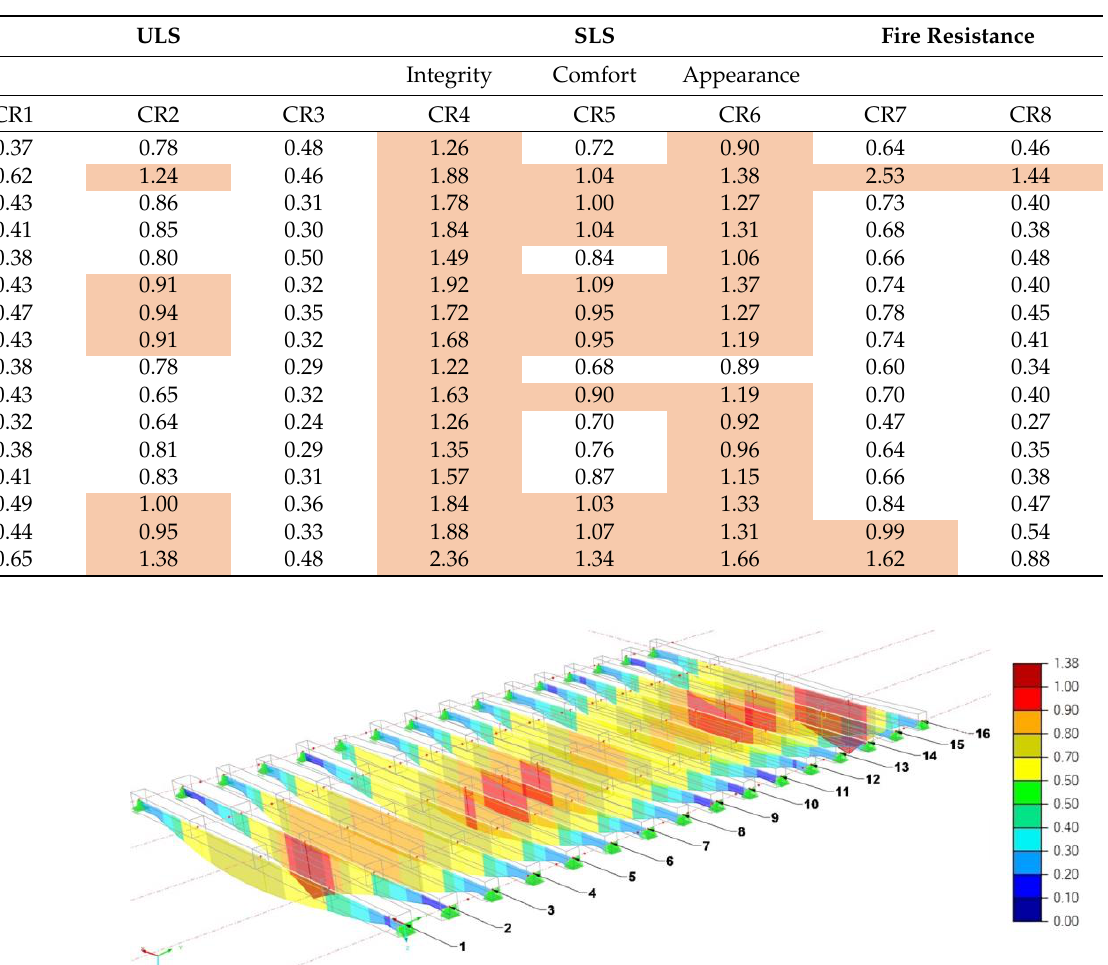
Table 5. Summary of results for each combination and load situation. Cases of almost non-compliance